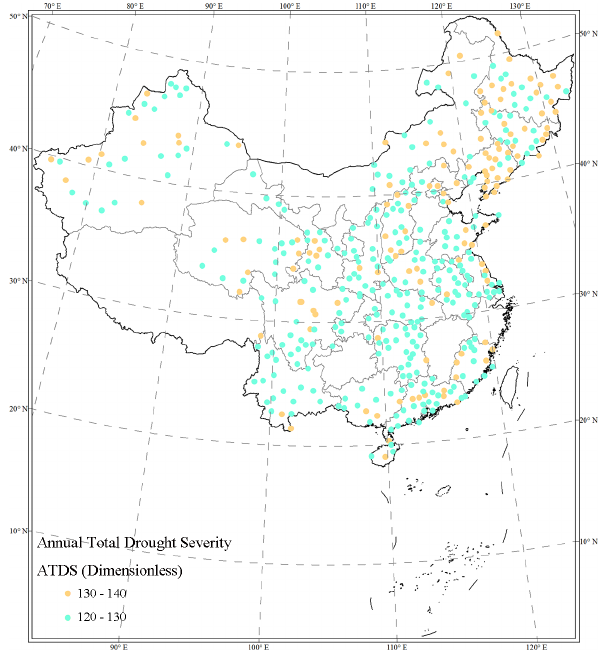
Figure 3. The spatial distribution of ATDS across mainland